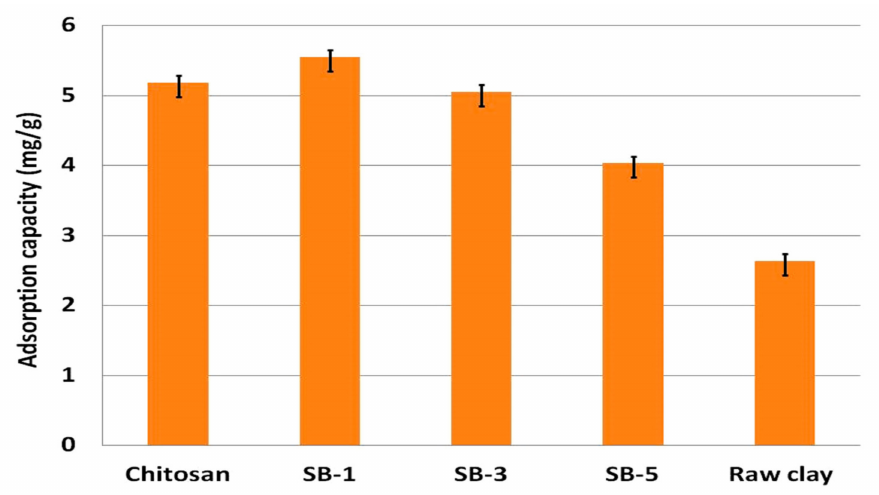
Figure 8. Removal of Pb (II) ions from standard solution by adsorbents.